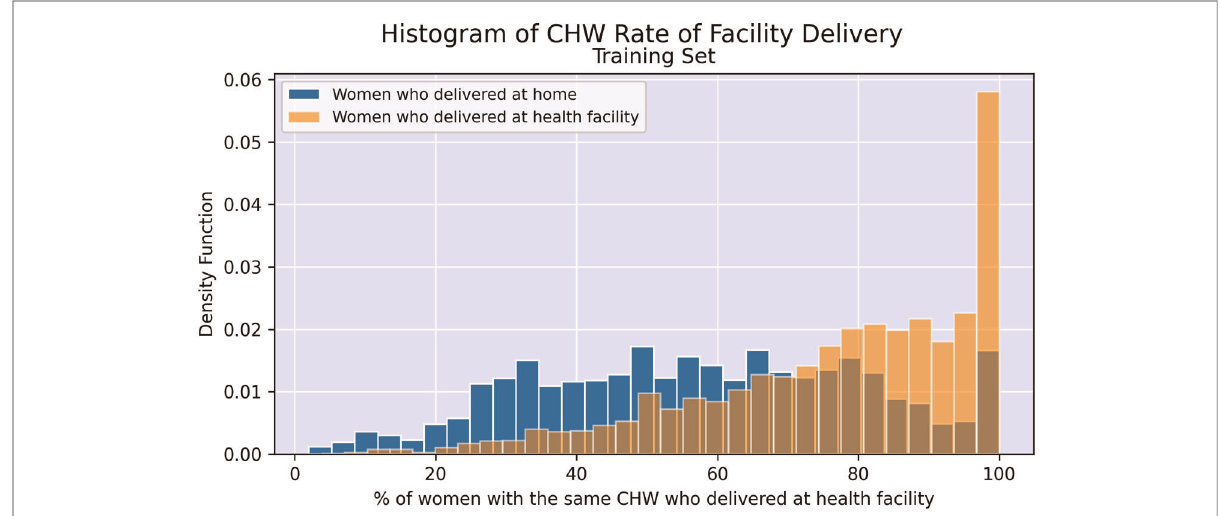
FIGURE 2 Histogram of facility delivery rates among women with the same community health worker.